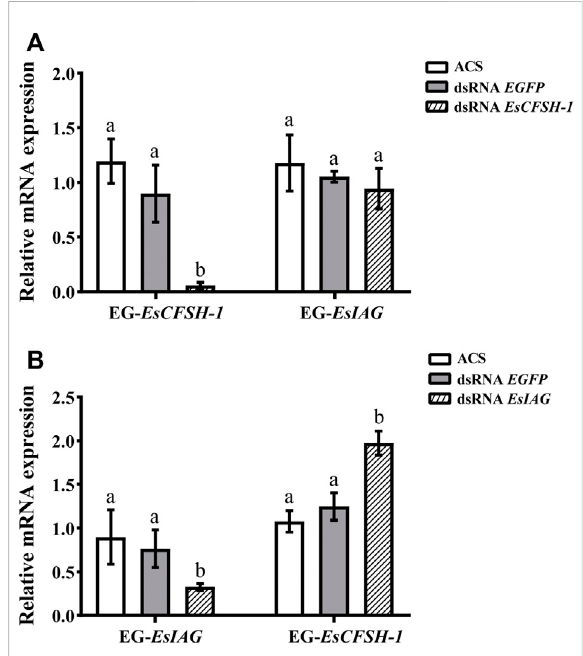
FIGURE 6 The expression pattern of EsCFSH-1 and EsIAG in the female (A) and male (B) embryos and larvae. Fe, fertilized egg stage; 2C, two-cell stage; Bs, blastula stage; Z3, zoea III stage; Z4, zoea IV stage; Z5, zoea V stage. The data were presented as means ± SEM ( n = 4). Signi fi cant differences of the gene expression levels were shown with four stars at p < 0. 0,001.